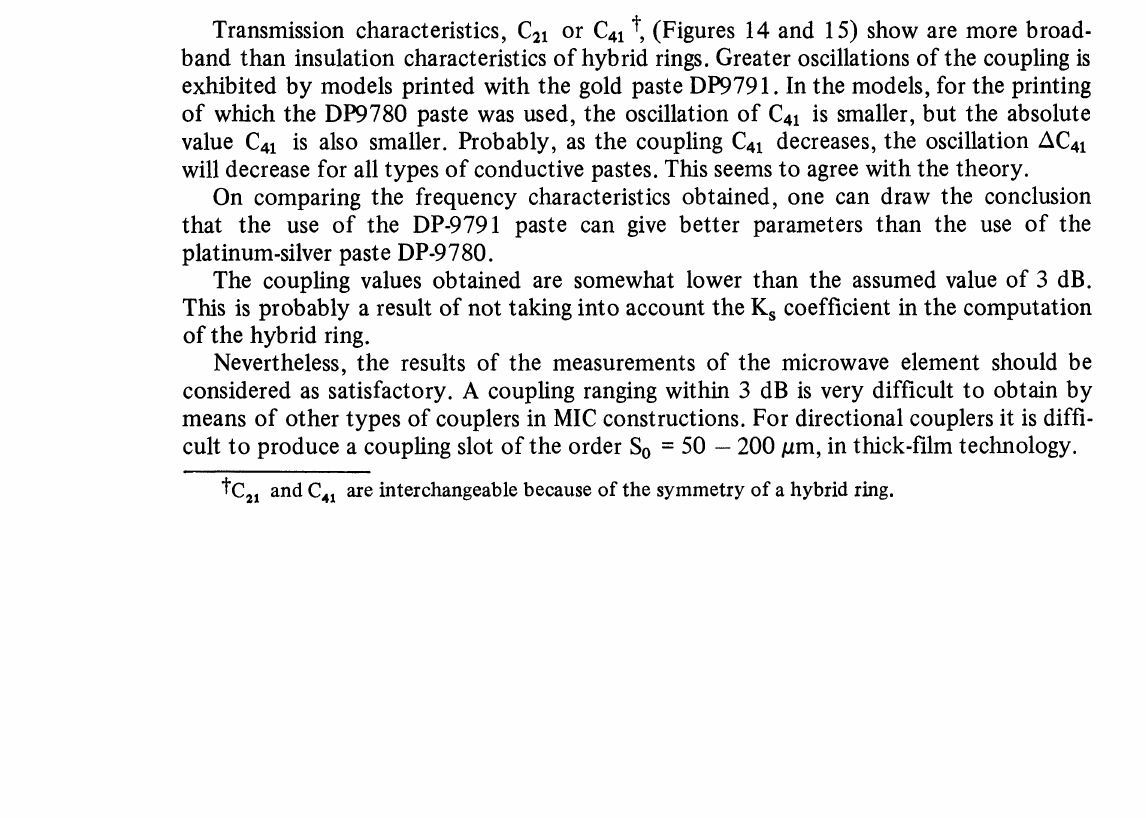
FIGURE 15 Frequency characteristics of C,I hybrid ring. Paste" DP9780" 330 Mesh, 260